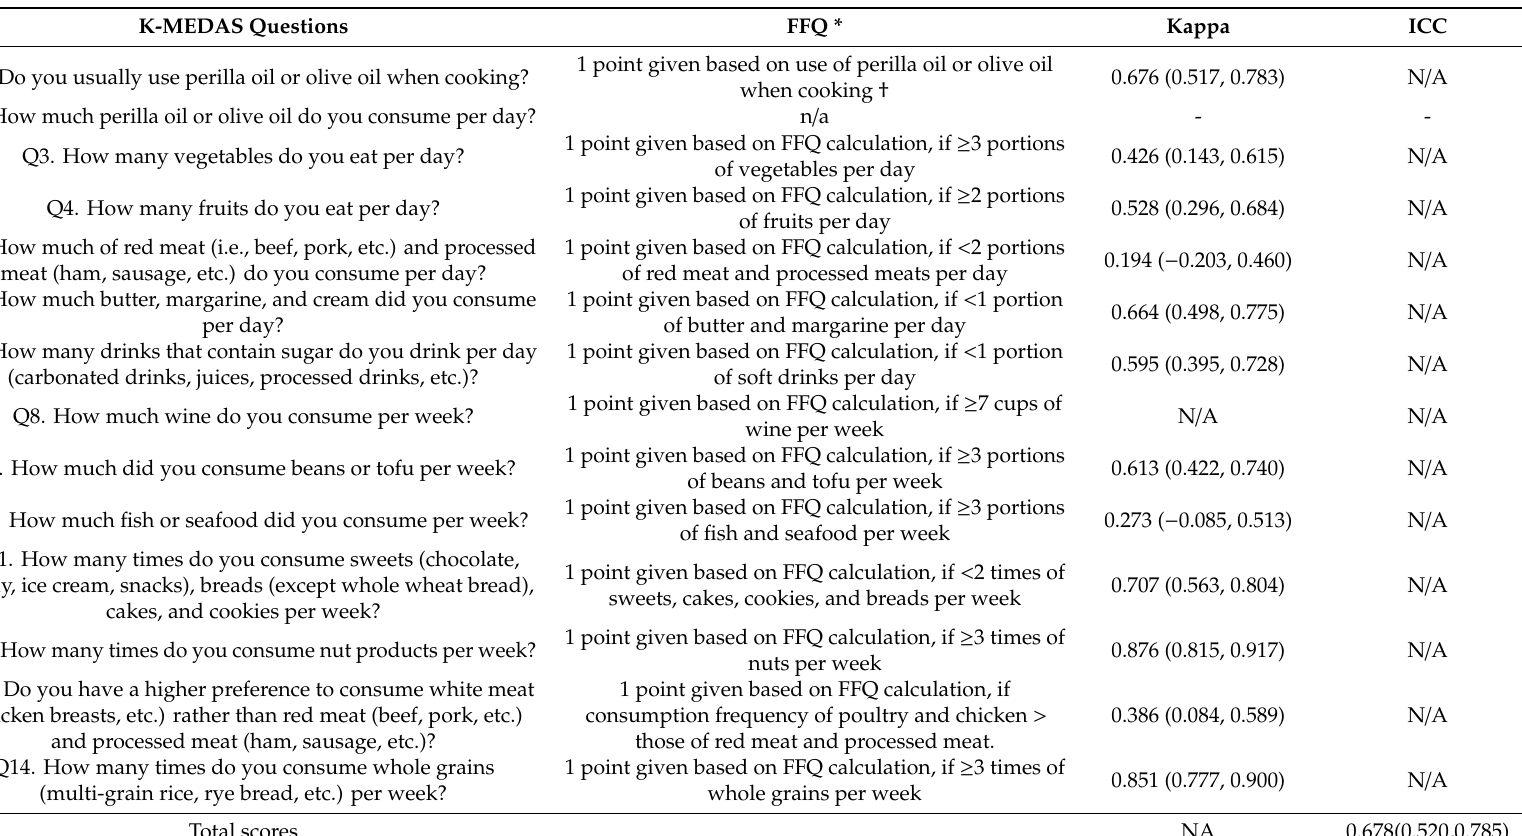
Table 2. Agreement of Korean MEDAS questions and transfer of food intake data from the